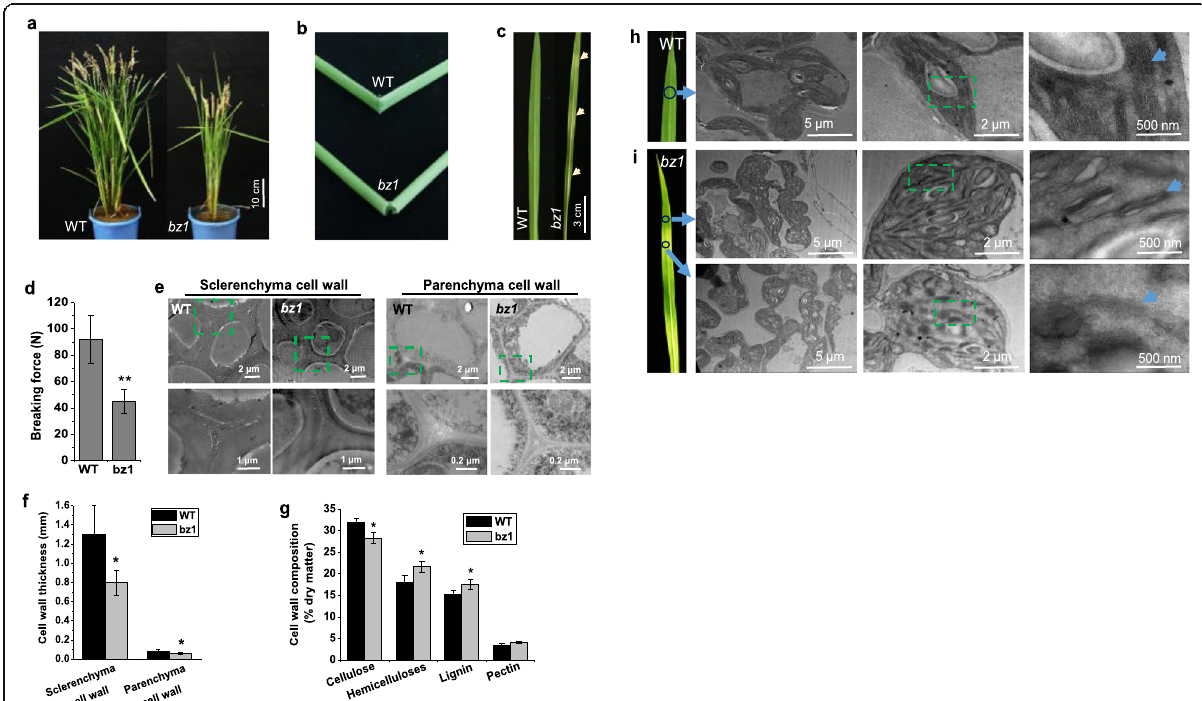
Fig. 1 The bz1 mutant displays both brittle culm and zebra leaf phenotypes. a Wild-type (WT) and bz1 plants at the mature stage. The images are representative of 20 plants for each genotype. b Folding of stems of WT and bz1 to show brittleness. c Leaf color of WT and bz1 at the seeding stage. d Measurements of the breaking force (Newtons) of basal stem internodes. e TEM micrographs of sclerenchyma and parenchyma cells. f Measurement of cell wall thickness shows thinner walls in bz1 compared with the WT. g Cell wall composition of mature stem. * indicates significant differences between WT and bz1 by t -test at P < 0.05. h-i Chloroplast structures in leaves of WT ( h ) and bz1 ( i ) at the tillering stage. The images are representative of six plants for each